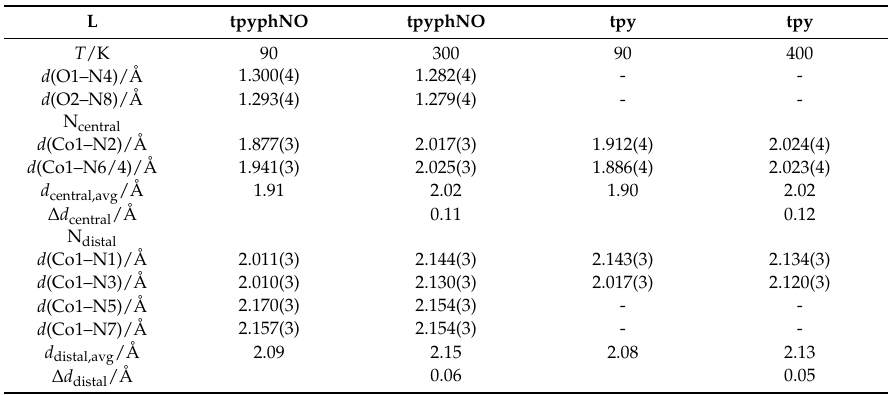
Table 2. Co–N bond distances ( d ) in Å for [Co(L) 2 ](CF 3 SO 3 ) 2 (L = tpyphNO, tpy).